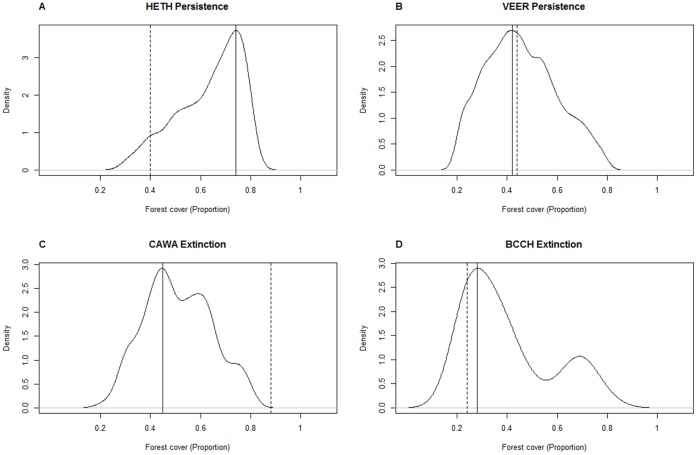
Kernel density plots of estimated breakpoints for all subsamples (out of 5000).We superimposed an estimate of the proportion of forest cover (the threshold) associated with the maximum kernel density of our sampling results (vertical full line) and the threshold derived by Zuckerberg and Porter (2010) (vertical dotted line). Panel A shows results for models of persistence for Hermit Trush (Catharus guttatus), Panel B persistence for Veery (Catharus fuscescens), Panel C extinction for Canada Warbler (Wilsonia canadensis) and Panel D extinction of Black-capped Chickadee (Poecile atricapilla). Results for the species shown were exemplary for situations where the estimated thresholds seemingly matched with (Veery, Black-capped Chickadee) or deviated from (Hermit Trush, Canada Warbler) the proportion of forest cover associated with maximum kernel density. Similar plots for all species can be found in Figure S2.